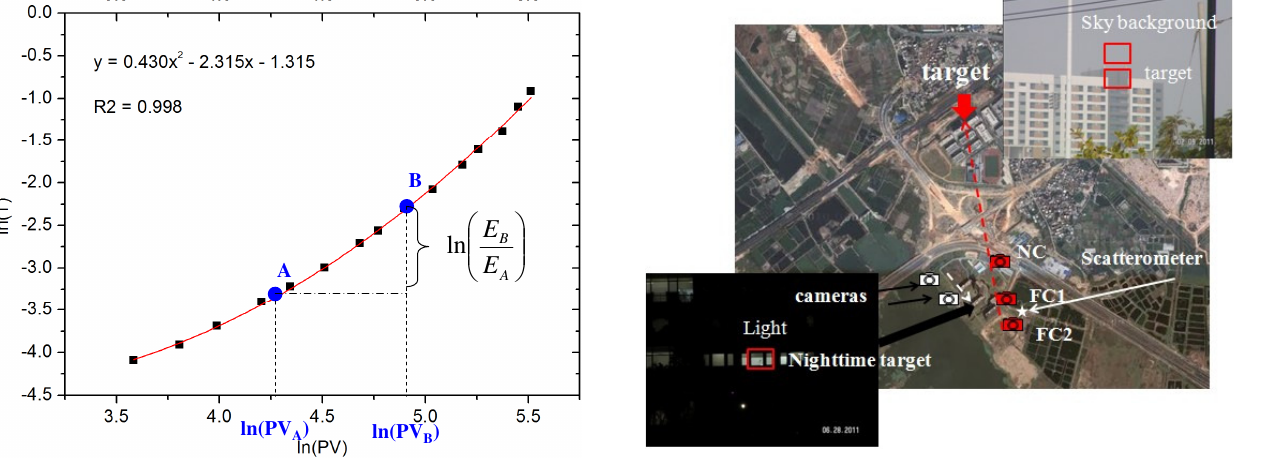
Fig. 2. Calibration: camera response curve for Konica Minolta Z2. Figure 2. Calibration: camera response curve for Konica Minolta Z2. 478